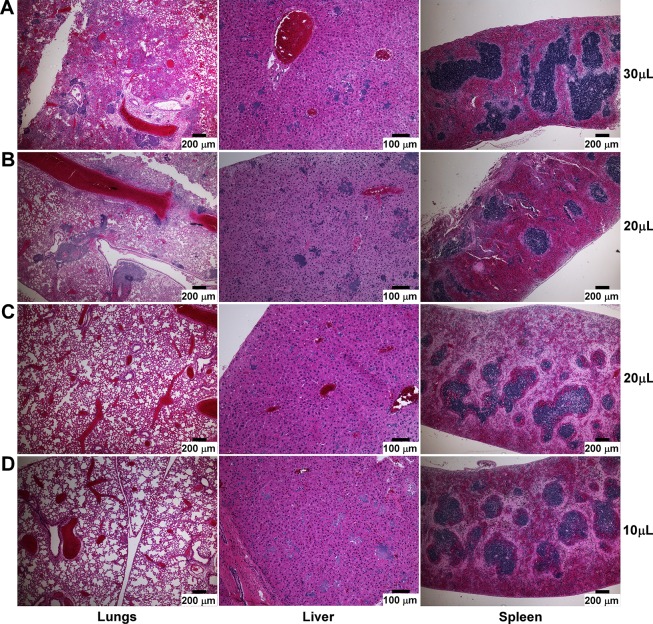
Frequency of septicemic plague in the absence of primary pneumonia increases with decreasing dosing volume.Representative lesions from mice challenged with 2,000 CFU of wild type Y. pestis in Fig 1 that succumbed to disease on day 4. Formalin fixed tissues collected at necropsy were sectioned and stained with hematoxylin and eosin (H&E). (A) 30μL group; (B-C) 20μL group, high (B) and low (C) severity scores in the lungs; (D) 10μL group. Scale bar represents 100μm (liver) or 200μm (lungs and spleen).